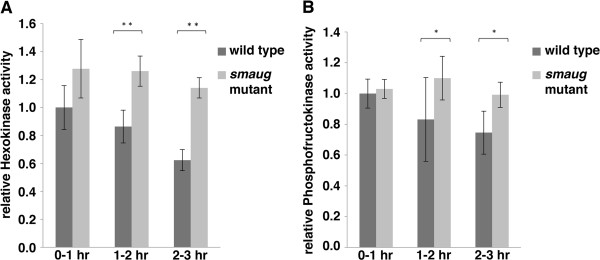
Glycolytic enzymes are overexpressed in smaug-mutant embryos. Extracts were prepared from 0- to 1-, 1- to 2- and 2- to 3-hour old wild-type and smaug-mutant embryos and assayed for (A) hexokinase activity or (B) phosphofructokinase activity. Activities are shown relative to the wild type 0 to 1 hour time point in each case. Results are the average of three independent experiments and error bars indicate standard error of the mean. Data were analyzed using a Student’s t-test (**P < 0.05, *0.05 < P <0.1).